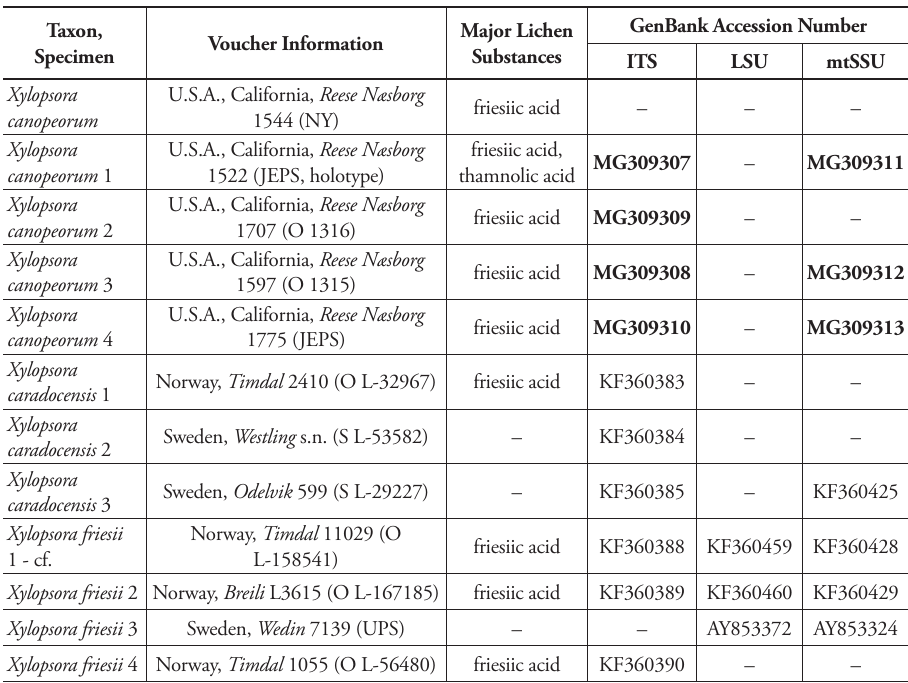
* DNA sequences obtained from different vouchers; checked for gene-tree incongruence prior to concatenation. ** DNA sequences shorter that 200 bp and therefore not accepted for submission to GenBank. See Ben- diksby and Timdal (2013) for